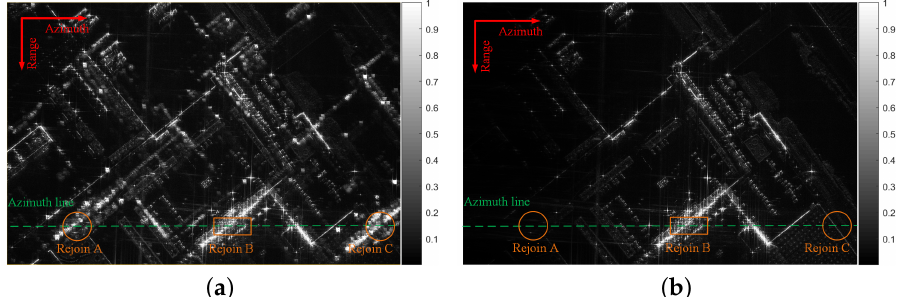
Figure 11. Reconstruction results of the equivalent multichannel SAR data (by amplitude normaliza- tion). ( a ) Reconstruction by IDR; ( b ) reconstruction by SILAMER.